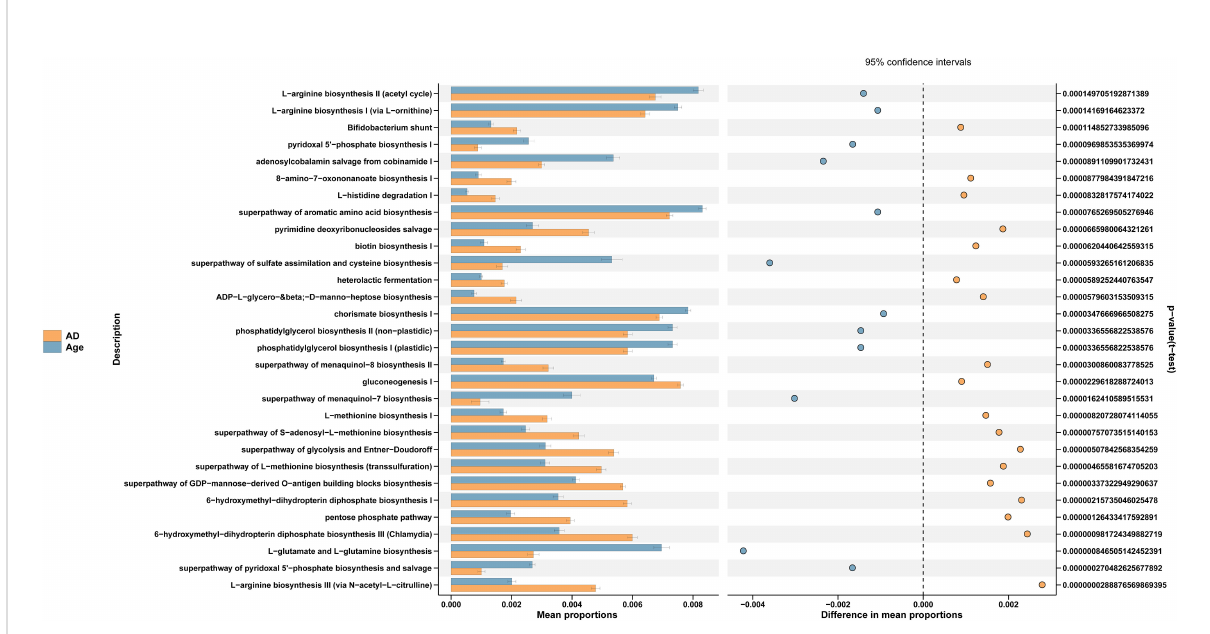
FIGURE 6 PICRUSt analysis. Functional prediction pathways in microbial differences among the